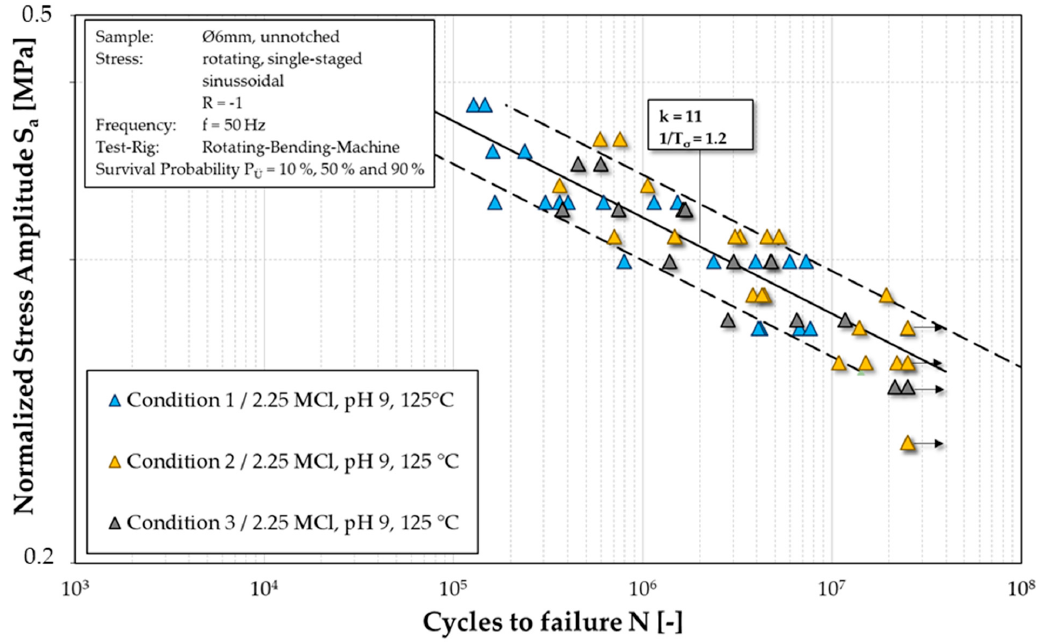
Figure 4. Results from the CF tests displayed in a double logarithmic Wöhler diagram. The stress amplitudes are normalized according to the respective tensile strength of the metallurgical condition. S/N curves are calculated with a survival probability of 10%, 50% and 90% respectively.